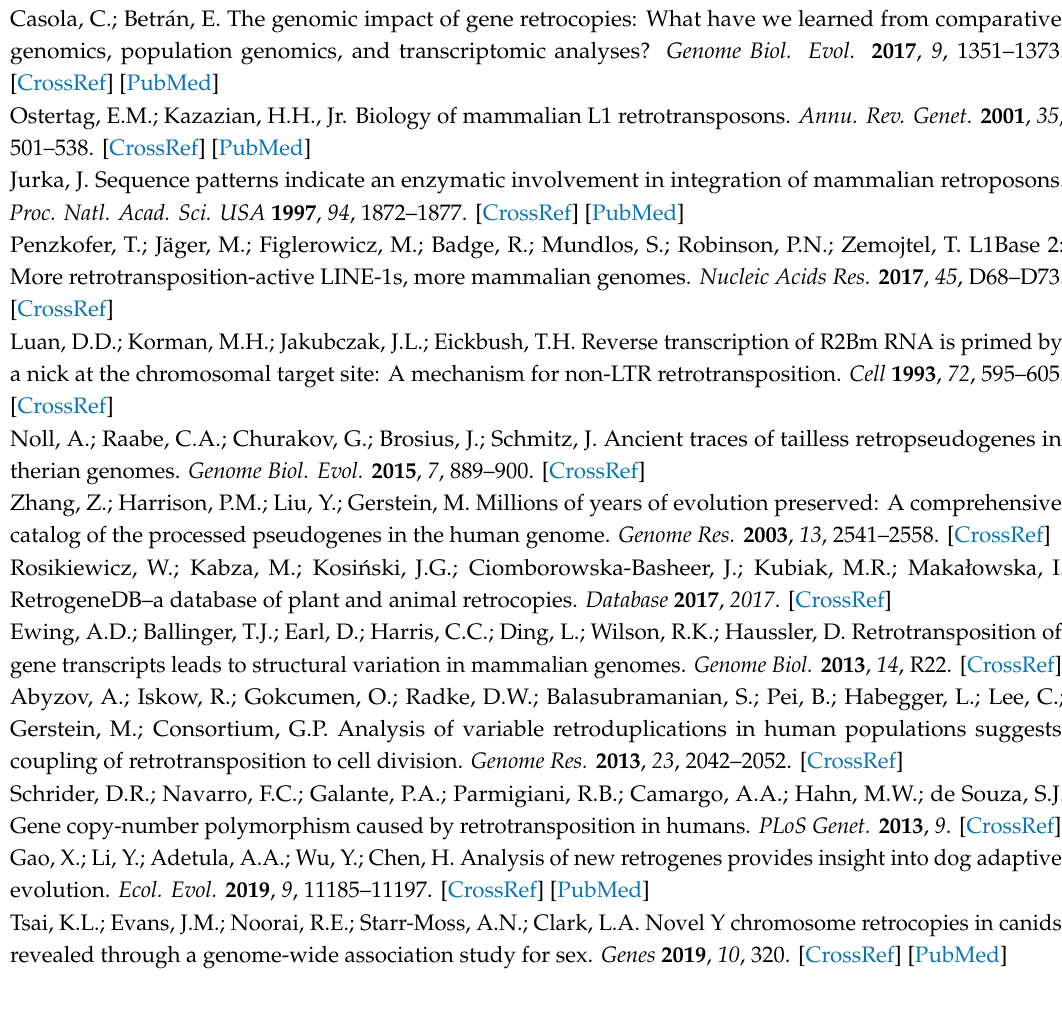
Figure S1: Retrocopy discovery from whole-genome sequencing data; Figure S2: FGF4 genotyping assay;